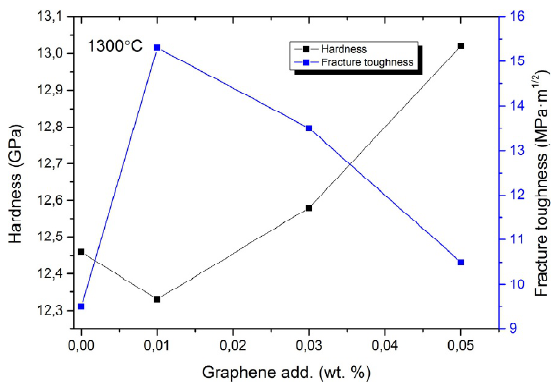
Fig. 6. Mechanical characteristics (hardness and crack resistivity) of the zirconia-graphene compos- ites (3YSZ-GNP) synthesized by PAS approach [84].